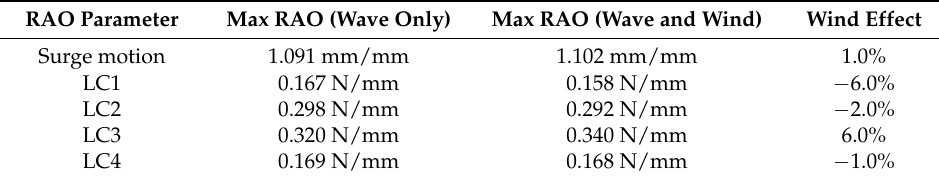
Table 10. Maximum RAO values of the TLPWT model at T = 1.23 s.